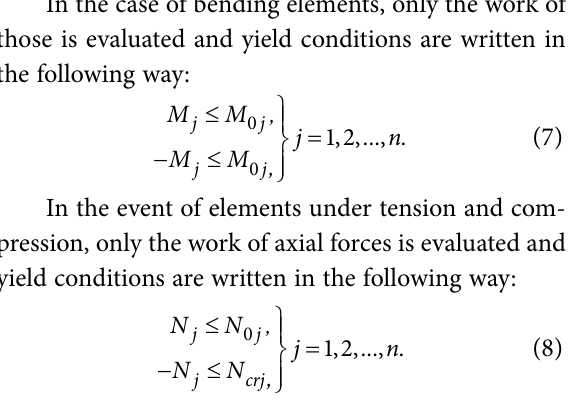
Table 1. The coefficients of geometric characteristics of profiles Web Type of a thickness, a 1 cross-section mm Rectangular 5 0,0668 2,9665 0,2303 1,9851 Rectangular 6,3 Rectangular